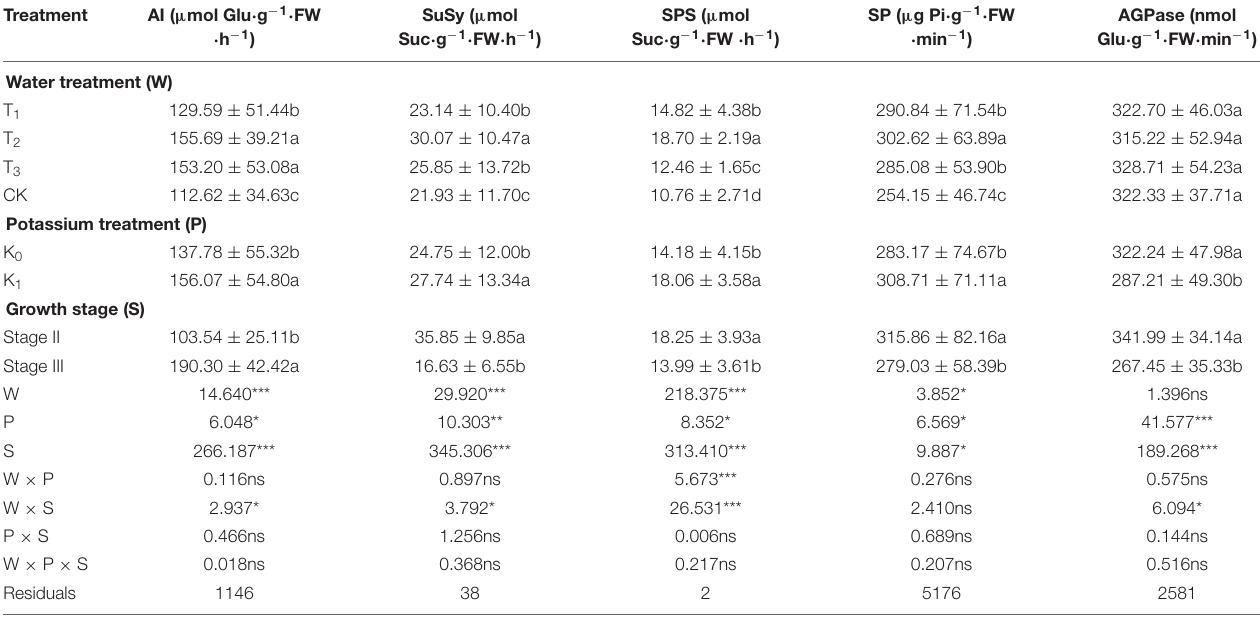
TABLE 5 | Three-way analysis of variance of fruits AI, SuSy, SPS, SP, and AGPase, were performed to identify individual and interactive effects of water, potassium and growth stage on the tomato fruits.